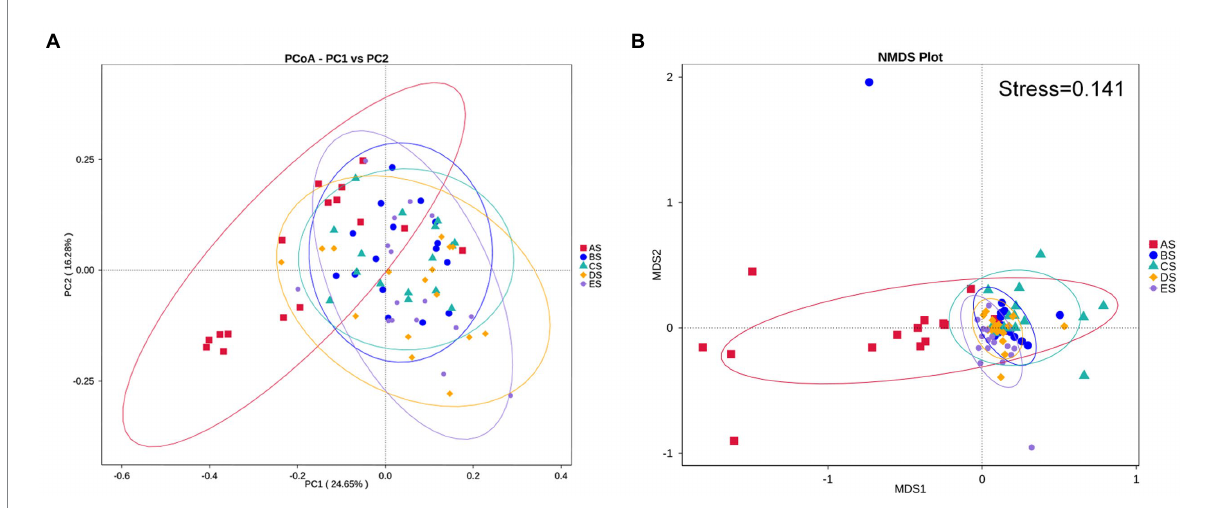
FIGURE 2 Structural discrepancy of microbial communities, assessed via by (A) PCoA based on weighted UniFrac distance and (B) NMDS based on Bray– Curtis distance. Each point represents one sample, and the same color represents the samples of the same